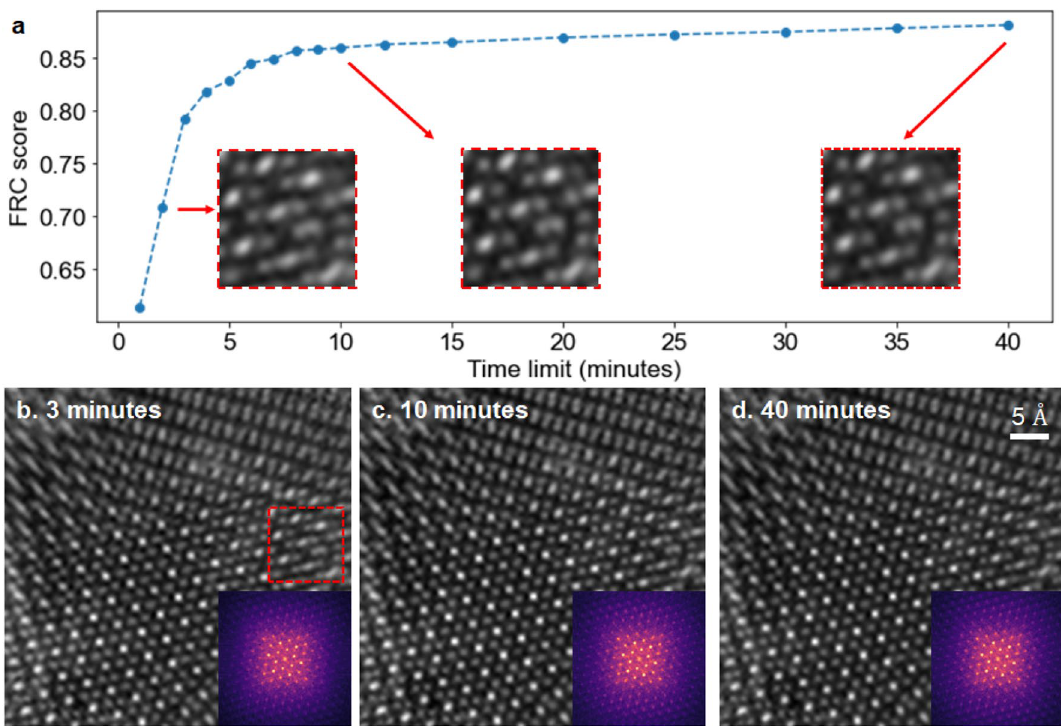
Figure 4. Ptychographic reconstructions of bilayer MoSe 2 /WS 2 at different time limits. The best reconstruction parameters at each time limit were automatically optimized by BO. ( a ) Best FRC scores vs. reconstruction time. ( b – d ) Best reconstructions and their diffractograms (insets) after 3, 10, and 40 min, respectively. The zoom-ins in ( a ) shows that reconstructed atoms become more resolved as time